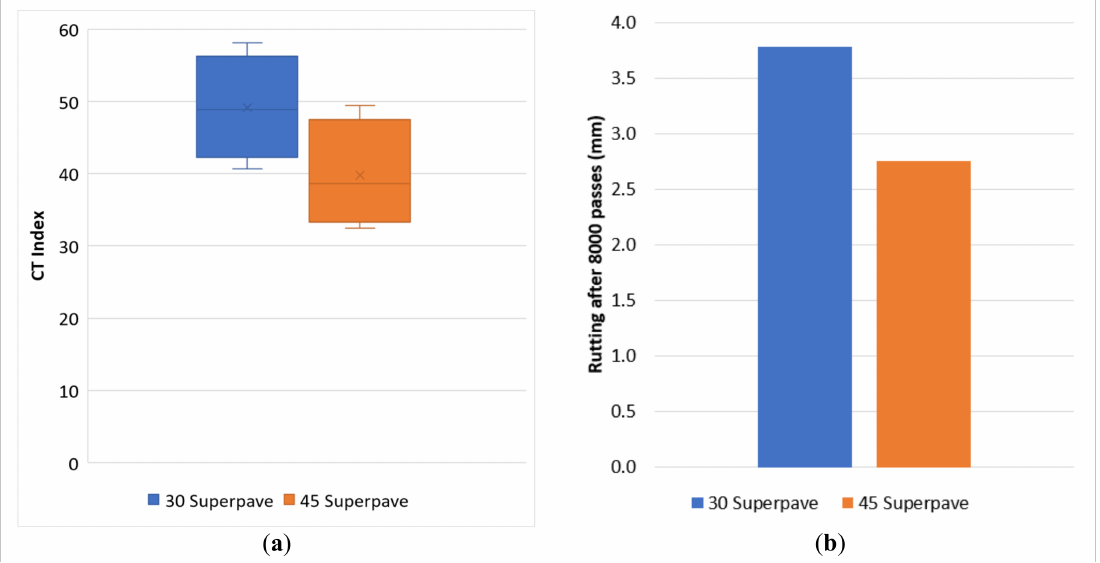
Figure 3. CT Index ( a ) and APA ( b ) results for control